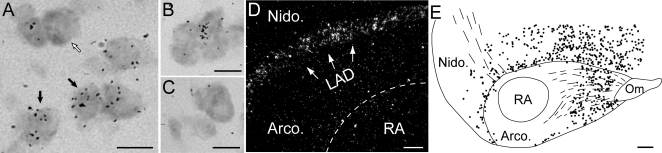
(A–C) Bright-field high power Nissl stained views of NRP1 emulsion autoradiography at the level of HVC. Black arrowheads indicate examples of small cells with high levels of emulsion grains (A), white arrows point to larger neurons with no detectable expression (see also C). (D) Low power dark-field autoradiography for SEMA3A in a parasagittal section at the level of RA. Note intensely labeled cells that align along the lamina arcopallius dorsalis (LAD). (E) Camera lucida drawing of the ventral nidopallium and arcopallium from the section shown in D. Individual cells expressing SEMA3A are represented by solid circles. For anatomical abbreviations see text. Scalebars: 10 µm in A–C; 100 µM in D; 1 mm in E.